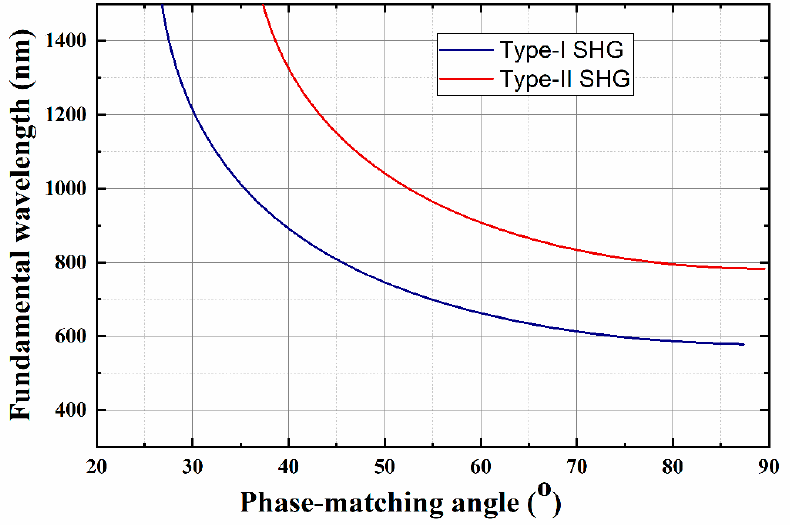
Figure 14. Phase-matching curves for SHG of types I and II in the LYSB crystal. (Reprinted with Figure 14. Phase ‐ matching curves for SHG of types I and II in the LYSB crystal. (Reprinted with permission from ref. [13], copyright 2019 American Chemical Society). permission from ref. [13], copyright 2019 American Chemical Society).